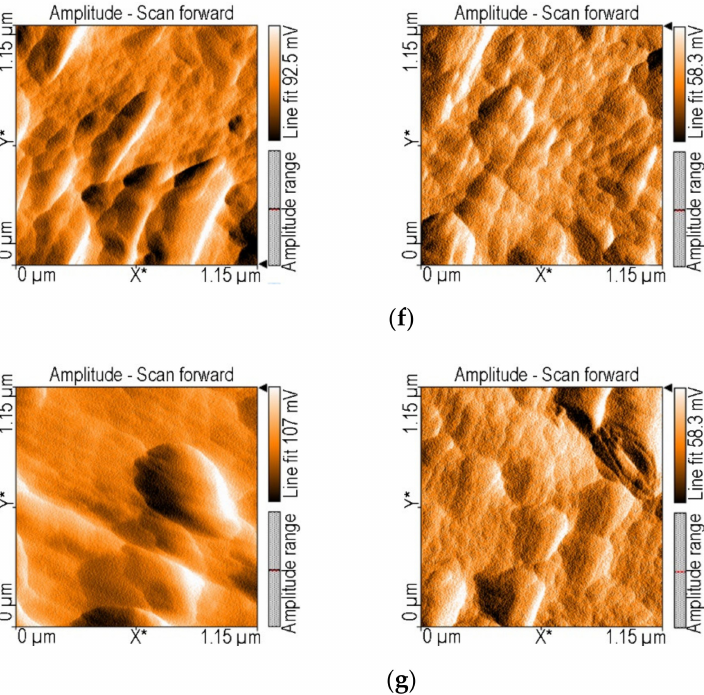
Figure 6. Two-dimensional AFM images for the covering layers, before and after corrosion tests: OL bare W1.4043; ( a ) MnTa 2 O 6 (h); ( b ) 5-(4-carboxy-phenyl)-10,15,20-tris (4-methyl-phenyl)- porphyrin; ( c ) 5-(4-methyl-benzoate)-10,15,20-tris (4-methyl-phenyl)-porphyrin; ( d ) 5-(4-carboxy-